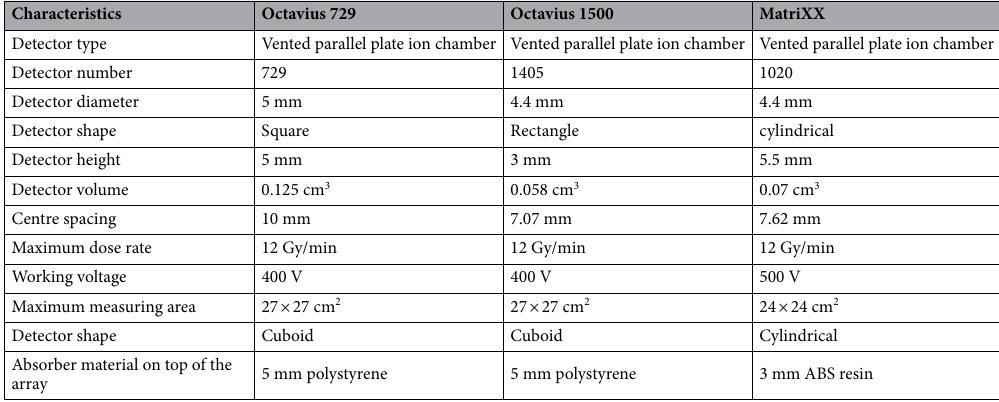
Table 1. Specifications of Octavius 729, Octavius 1500, and MatriXX ion chamber detector